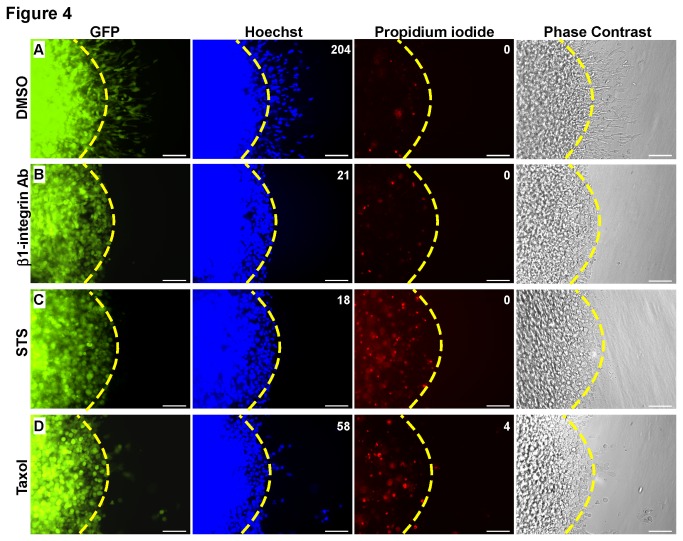
Simultaneous determination of invasion and cytotoxicity.HT1080 cells expressing GFP were assembled in the 3-D invasion assay in the presence of (A) DMSO, (B) anti-β1 integrin antibody (5 μg/ml), (C) staurosporine (STS) (500 nM), or (D) paclitaxel (Taxol, 1 μM) for 18 hours. The cells were stained with Hoechst and propidium iodide (PI) for 30 minutes followed by microscopic examination. Decreased cell invasion is observed upon treatment with anti-β1 integrin antibody, STS, and taxol. However, STS and taxol show higher levels of PI staining, indicative of increased cell death. Numbers in the top right corners represent the total number of invasive cells (Hoechst images) or cells that died after invading (PI images) within the field. Scale bar = 100 μm.